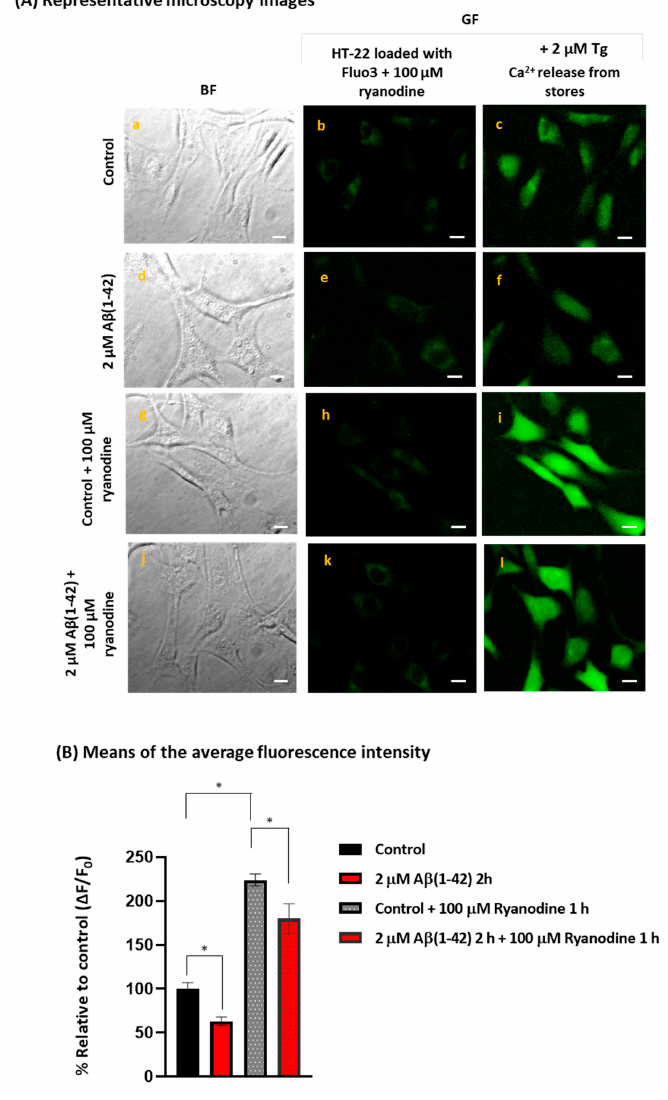
Figure 7. A β (1-42) partially stimulates RyR activity after 2 h of incubation in HT-22 cells. Untreated (control) and treated HT-22 cells with 2 μ M A β (1-42) for 2 h were loaded with Fluo3-AM plus 0.025% Pluronic ® F-127 in the absence and presence of the RyR inhibitor ryanodine (100 μ M) for 1 h at 37 °C. Panel A : representative microscopy images of untreated (control) and cells treated with